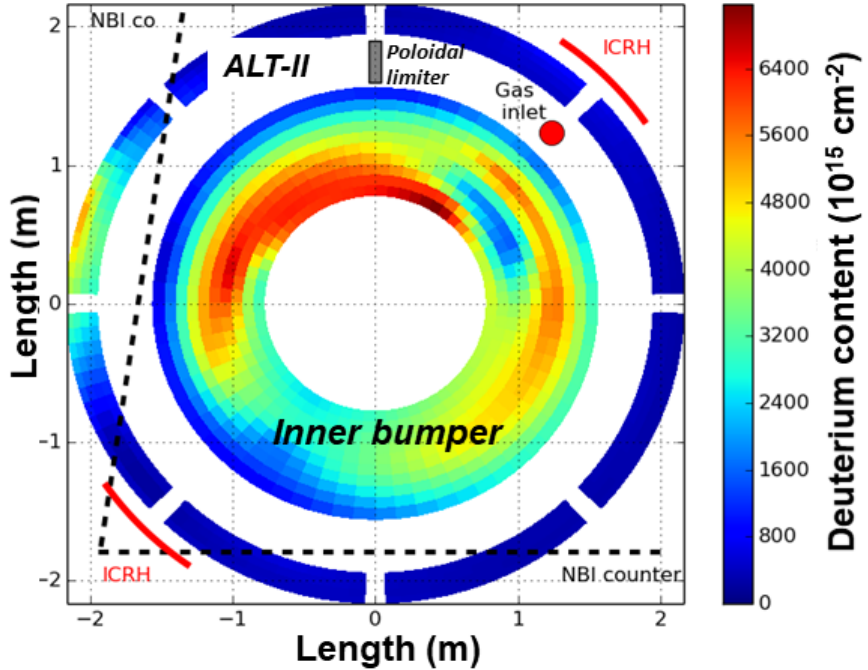
Figure 8. Mapping of the total deuterium content on the PFC of TEXTOR. “ICRH” stays for ion cyclotron resonance heating , “NBI” denotes neutral beam injection (co-injector and counter injector), and “ALT-II” stays for Advanced Limiter Test